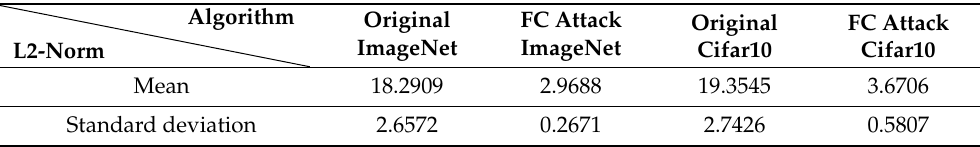
Table 7. L2-norm statistics between target test data and collision table data for FC attacks against ImageNet [37] and Cifar [10]